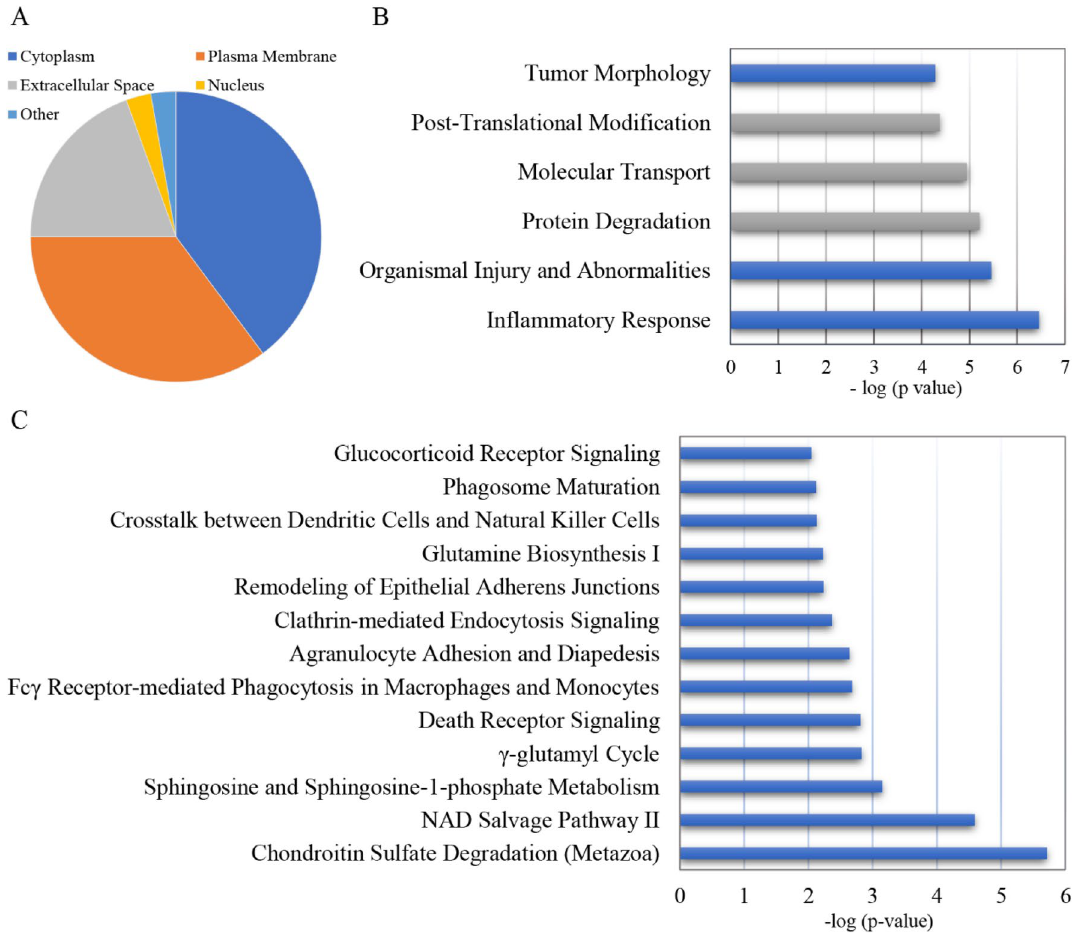
Figure 3. IPA functional annotation of the differentially expressed proteins in VILI rats. ( A ) Locations; ( B ) molecular cellular functions (gray bars), biological process (blue bars); ( C ) the top canonical